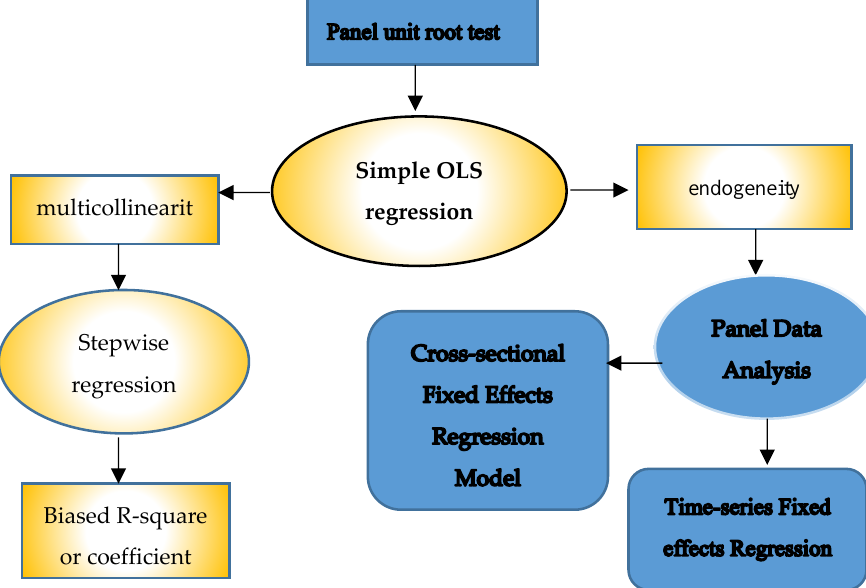
Figure 1. Modeling study framework.